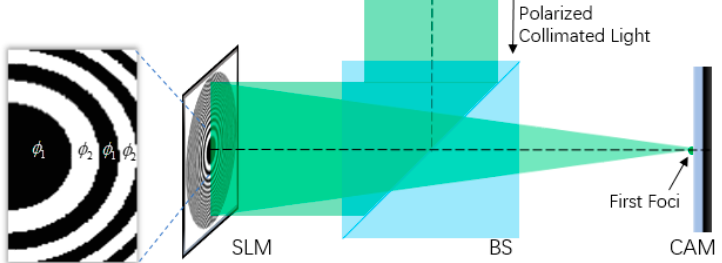
Figure 8. Schematic of an optical elements features analyzed method. BS: beam splitter; SLM: spatial light modulator; CAM: camera.